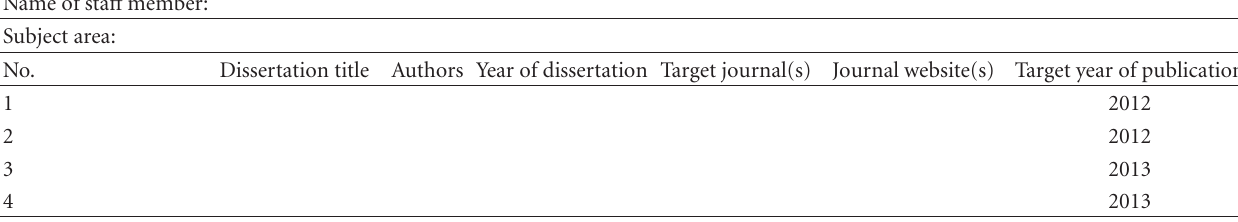
Table 14: REF personal publication programme.